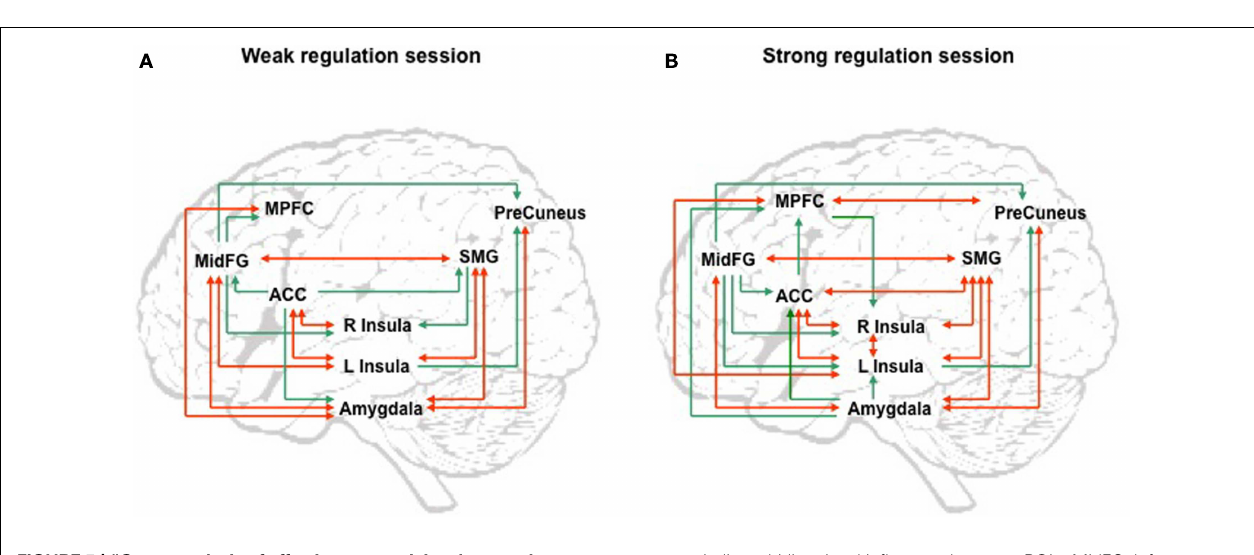
FIGURE 5 | “Group analysis of effective connectivity changes due to fMRI-BCI training using Granger causality modeling (GCM).” (A) Direct influences of the emotional network during self-regulation in the weakest regulation session. (B) Direct influences of the emotional network during self-regulation in the strongest regulation session. Red